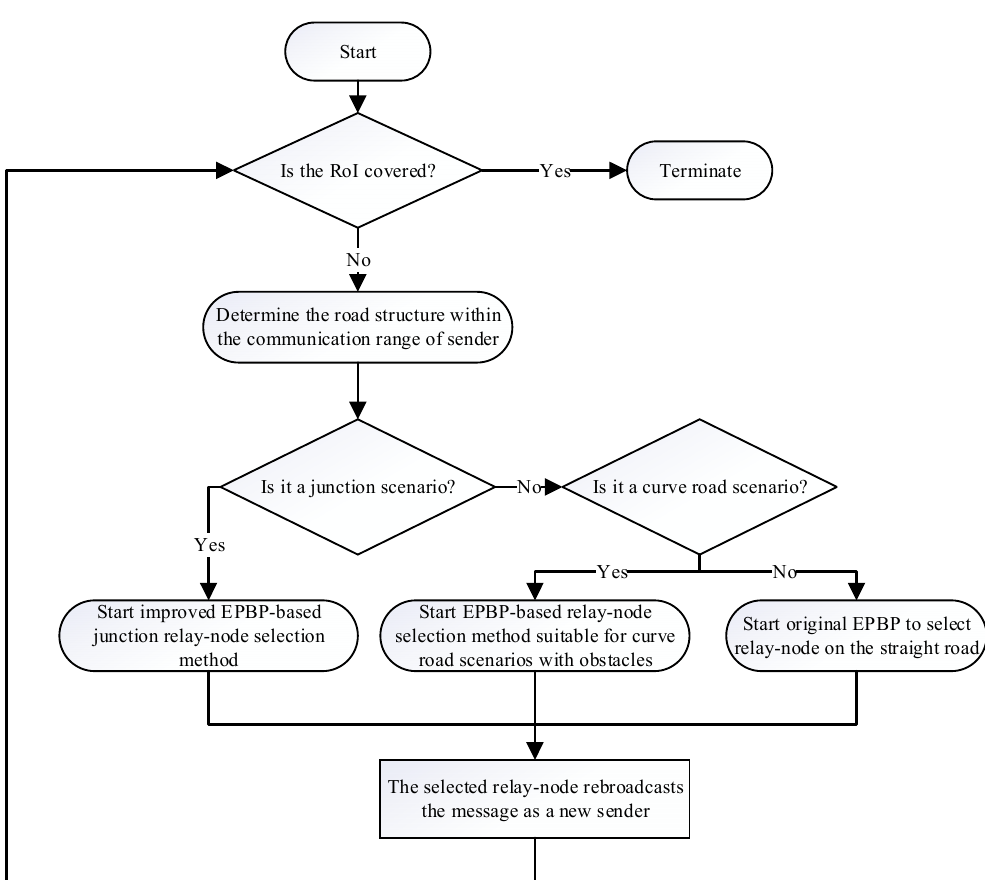
Figure 3. Flow diagram of adaptive relay-node selection (ARNS).